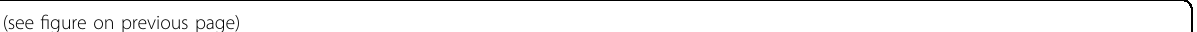
Fig. 4 SFRP4 + stromal cells promote the proliferation of endometrial epithelial organoid in vitro through regenerative IGF1 signaling. a Heatmap showed differentially expressed genes between SFRP4 + stromal cells and other stromal cell subsets. Among them, 15 secreted factors were signi fi cantly highly expressed in SFRP4 + stroma. b the transcriptional dataset (series: GSE4888) veri fi ed that the 15 secretory factors were speci fi cally highly expressed in proliferative phase. c Venn diagram of genes signi fi cantly highly expressed in SFRP4 + stroma (light gray) compared to secretory factors (dark gray), and interaction clusters of ligands from SFRP4 + stroma to receptors from the proliferative epithelial subset (purple). d organoids culturing of endometrial epithelia cells cocultured with SFRP4 + stroma from normal or IGF1 knockdown (IGF1si-stroma) cells, scale bar, 200 μ m. e quanti fi cation of endometrial epithelial organoids at different time points of co-cuture, ** p < 0.01; f diameter of endometrial epithelial organoids at different time points of co-cuture, * p < 0.05. g organoids culturing of endometrial epithelia cells with or without IGF1 inhibitors when cocultured with SFRP4 + stroma, 4 IGF1 inhibitors (s1012, s1034, s1091, s1093) are from Selleck.cn, scale bar, 200 μ m. h quanti fi cation of